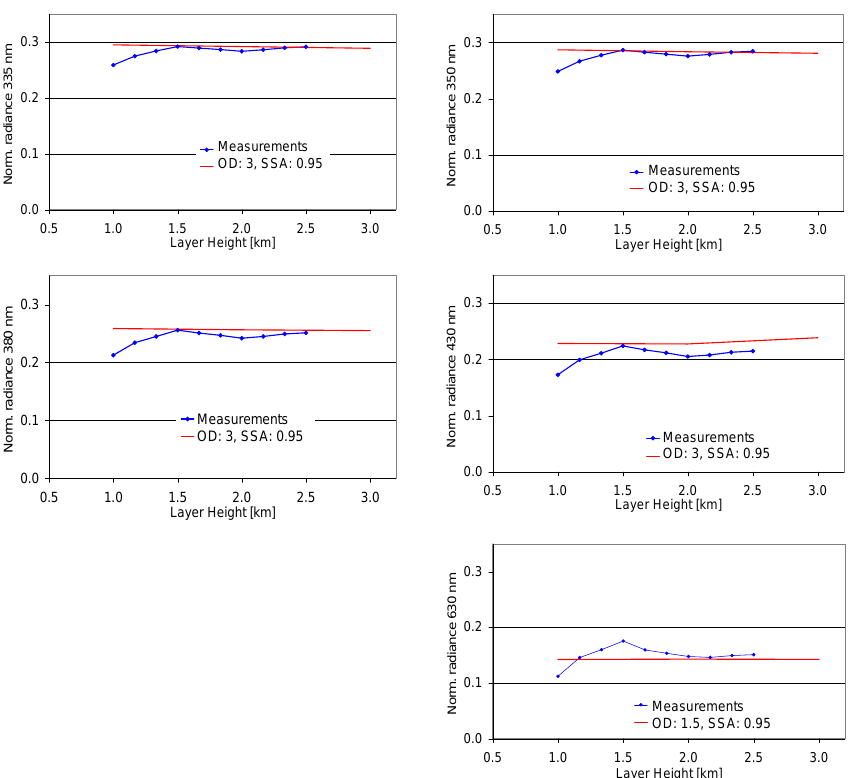
Fig. 16 Observed (blue dots and lines) and simulated (red lines) dependency of the normalised radiance on the aerosol layer height over the area south of Beijing on September 17, 2006 (see Fig. 14). For the radiative transfer calculations the following properties were assumed: surface albedo: 10% (630 nm) and 5% (all other wavelengths), aerosol SSA: 0.95; g: 0.68, AOD: 1.5 (630 nm) and 3 (all other wavelengths).